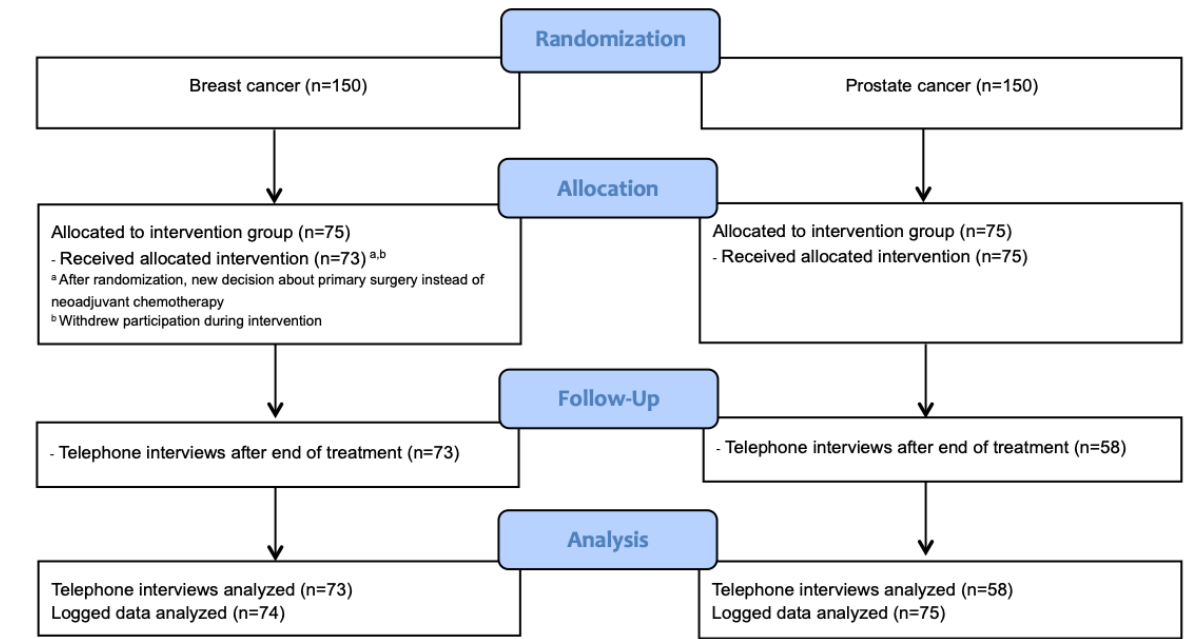
Figure 1. CONSORT